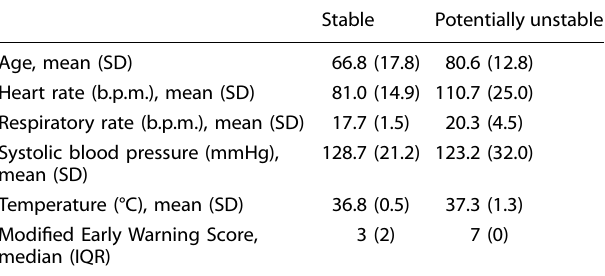
Table 2. Outcome-based model input